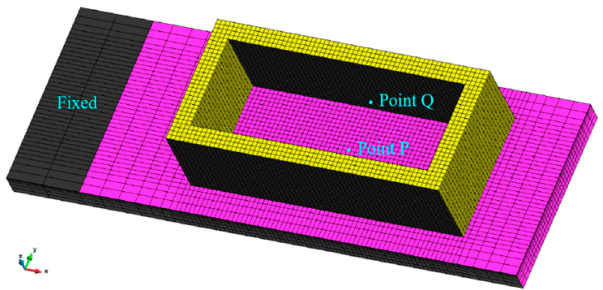
Figure 3. The finite element (FE) mesh model of the rectangular part used to calibrate the FE model.